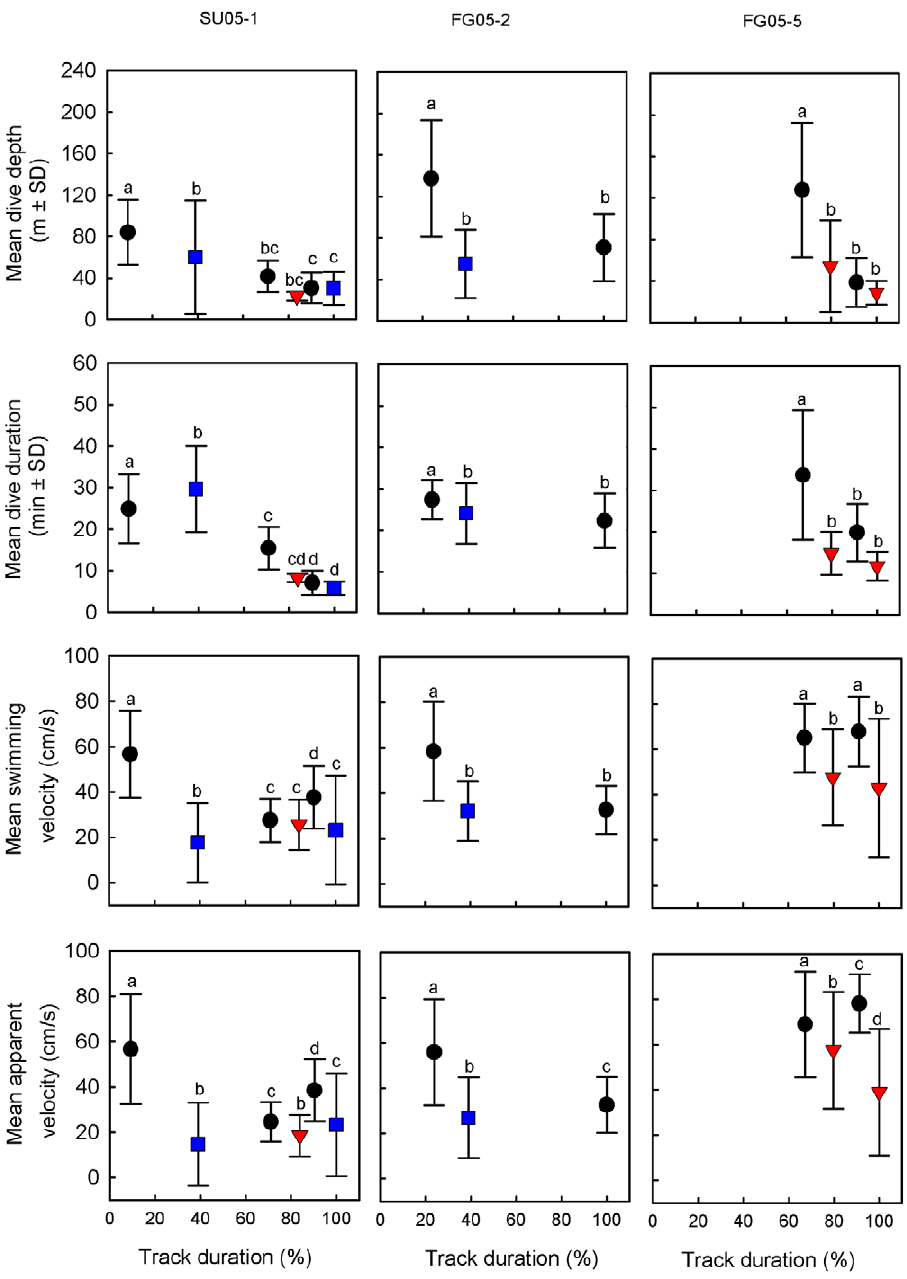
Figure 5. Variation in diving behaviour and velocities between areas. Diving behaviour and velocities in transit areas (filled dots), oceanic TRAs (filled crossed squares) and neritic TRAs (filled crossed triangles) for three Argos-tracked leatherback turtles nesting in Suriname (SU05-1) and French Guiana (FG05-2 and FG05-5) during their migrations in 2005. Differences between track sections were statistically tested using Kruskal-Wallis test followed by a post-hoc Bonferroni test. Different letters indicate significant (p , 0.05) differences among areas. Values are expressed as mean 6